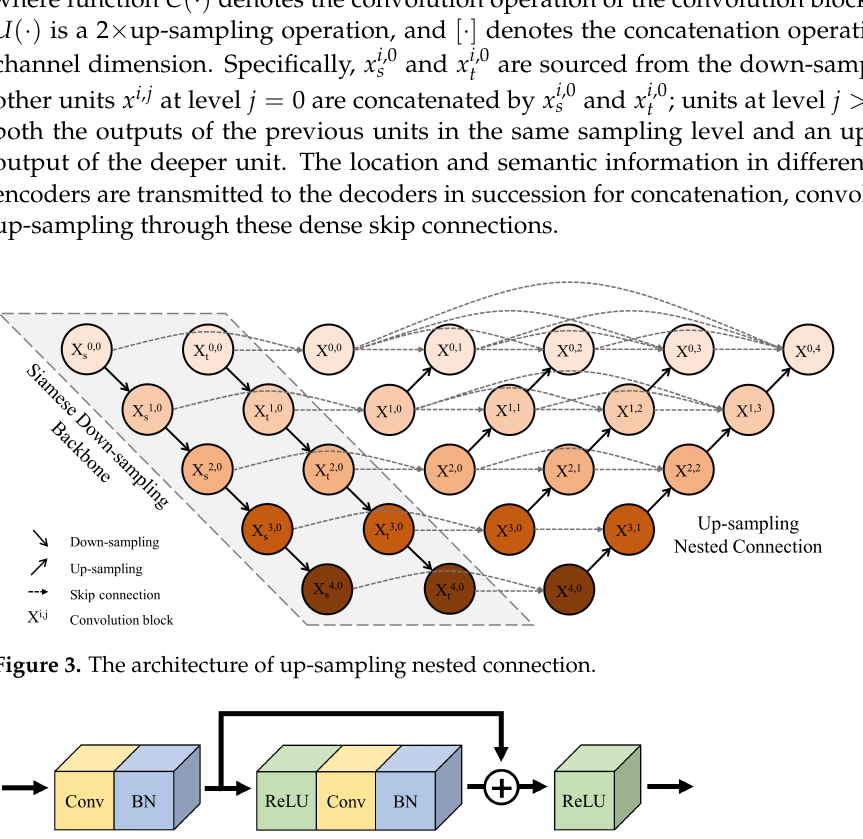
Figure 4. The structure of the convolution